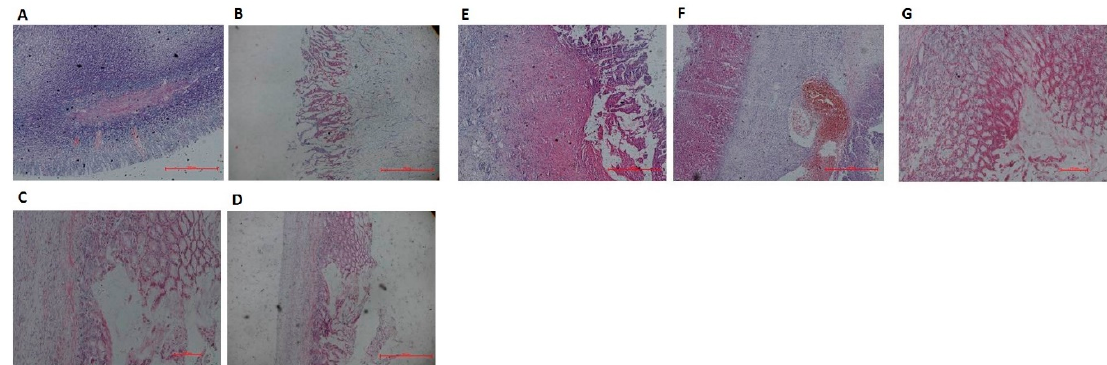
Figure 3. Effects of compound LSZ capsule on histopathological lesions of gastric mucosa in rats ( n = 6). A , Intact; B , Model; C , reference product of 30-mg enteric-coated capsules of LSZ (2.7 mg/kg);